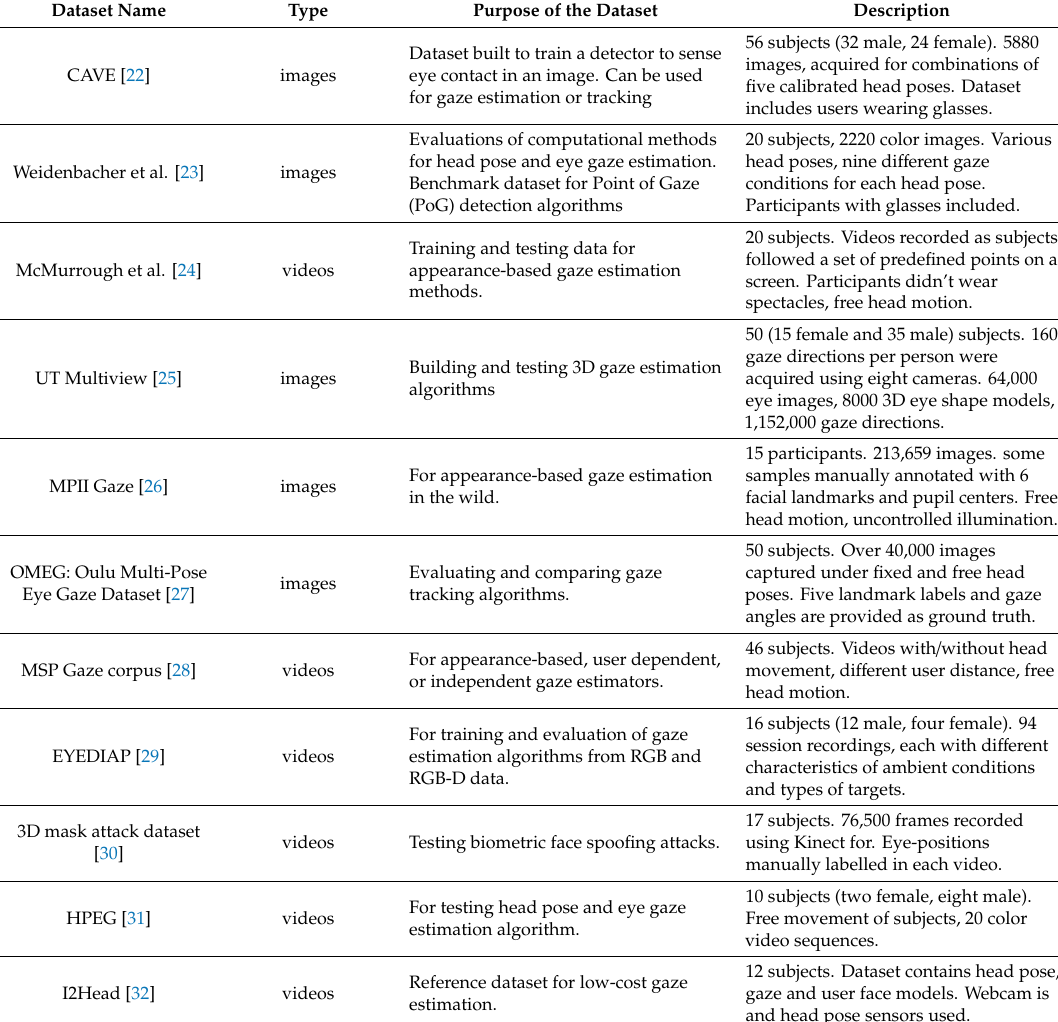
Table 1. Eye gaze datasets for building gaze estimation